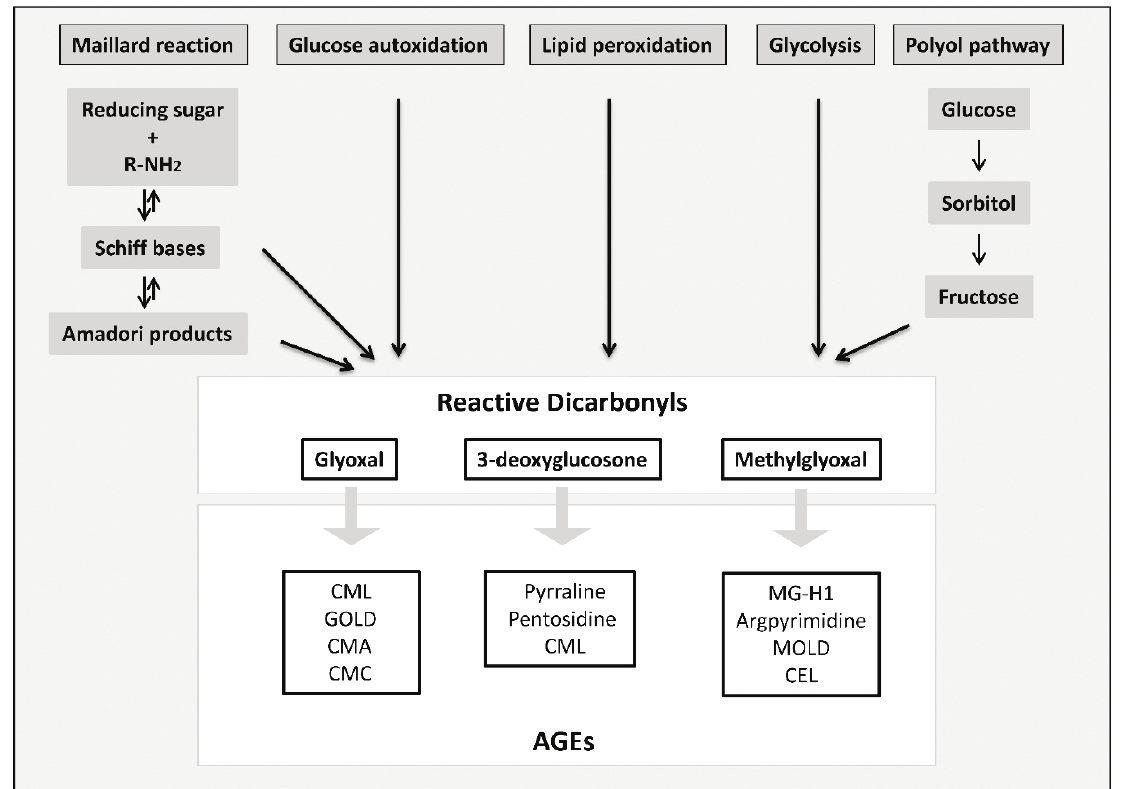
Figure 2. Formation of reactive dicarbonyls and AGEs, modified according to [29]. Reactive dicarbonyls including methylglyoxal, glyoxal and 3-deoxyglucosone are formed through several pathways: the Maillard reaction, the polyol pathway, glycolysis, lipid peroxidation or glucose autoxidation. Dicarbonyl compounds react further to form irreversible products, the so-called